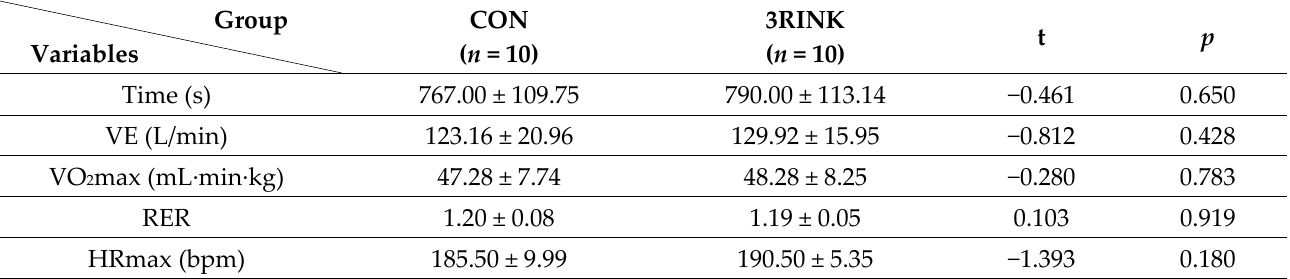
Table 3. Changes in exercise capacity.